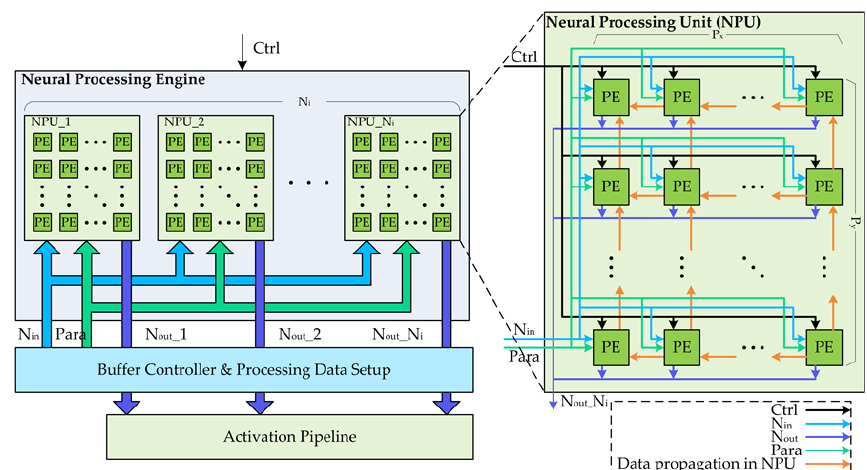
Figure 4. The hardware architecture of the neural processing engine. The left part is the neural processing engine consisting of multiple neural processing units (NPUs) and its data flow. The right part is the structure and data flow of a neural processing unit (NPU) composed of multiple processing elements (PEs).